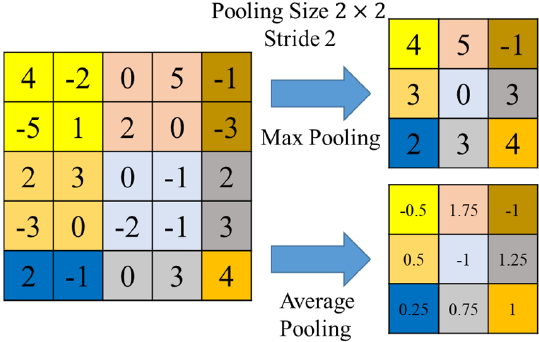
Figure 4. Schematic diagram of the convolutional layer operation.